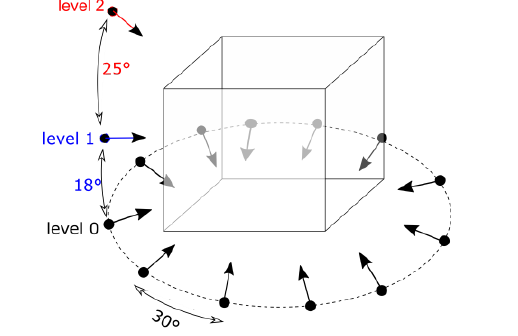
Results of accuracy evaluation tests in small volume according to VDI/VDE 2634.1 (2002) for ALPA 12 FPS add|metric (target type: r – reflective, s –